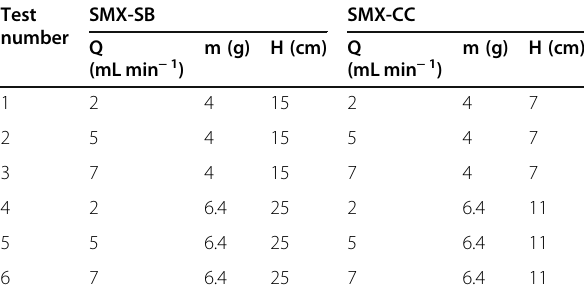
Column performance analysis